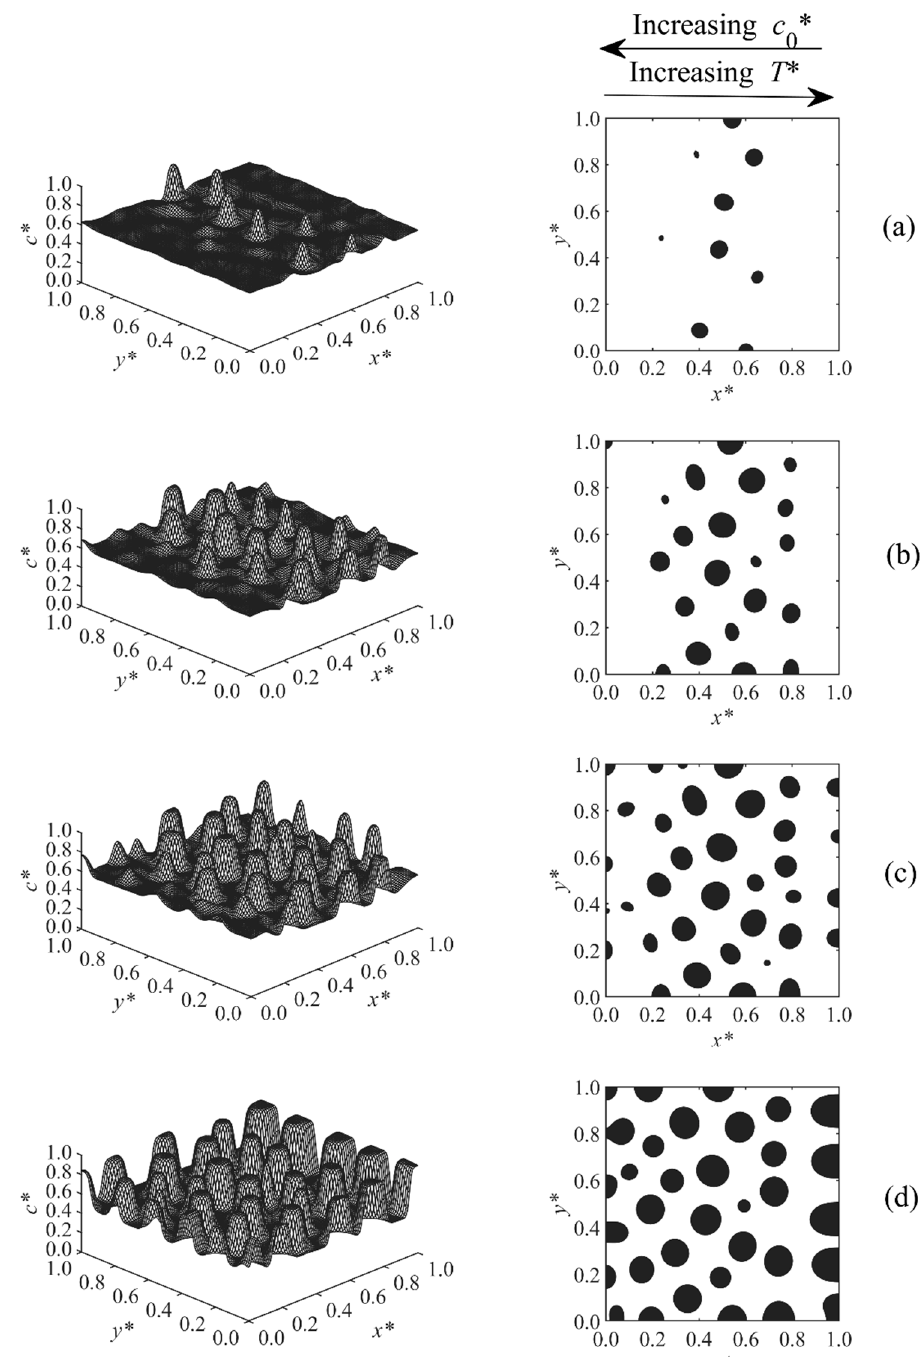
Figure 9. Spatial concentration profiles (first column) and phase-separated patterns (second column) for Case 8 at the following times: ( a ) t ∗ = 5.62 × 10 − 5 , ( b ) t ∗ = 5.65 × 10 − 5 , ( c ) t ∗ = 5.67 × 10 − 5 , and ( d ) t ∗ = 5.8 × 10 − 5 .